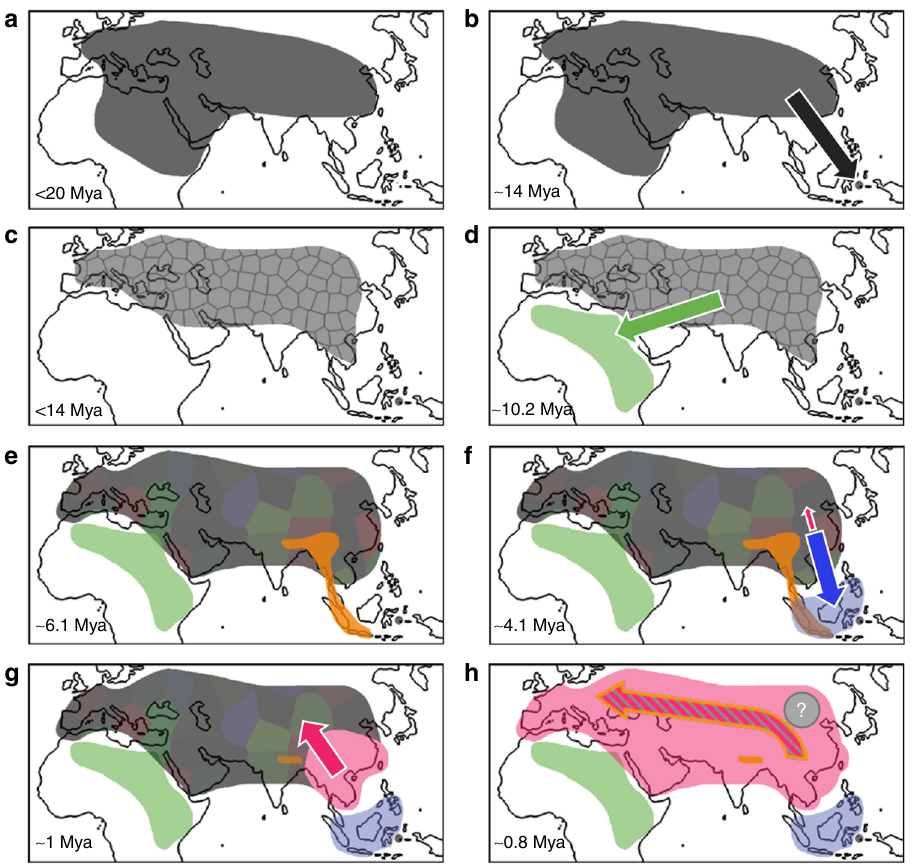
Fig. 1 A series of schematic models depicting the geographic evolution of Suidae species over the past 20 Mya. a Emergence of Suidae across Eurasian and Northern Africa. b The black arrow depicts the hypothesized trajectory of Babyrussa migrating to ISEA. c Emergence of Suinae (gray collage pattern) that replaced other Suidae . d The green arrow indicates the diversi fi cation of the ancestor of Sub-Saharan suids. e Eurasian Suinae split into multiple genera (multi-color collage pattern), including pygmy hog (orange shade). f The blue arrow depicts the migrations of Sus to ISEA. The red arrow indicates emergence of Sus scrofa . g , h . The spread of Sus scrofa from southern Asia to Europe and replacement of all Suinae species except pygmy hog. During the replacement, Sus scrofa populations introgressed at least three times with one of these Suinae species (ghost linage), pygmy hog and ISEA Sus , respectively. The colors correspond to those used in Fig. 2 and represent the cluster on the tree to which the samples